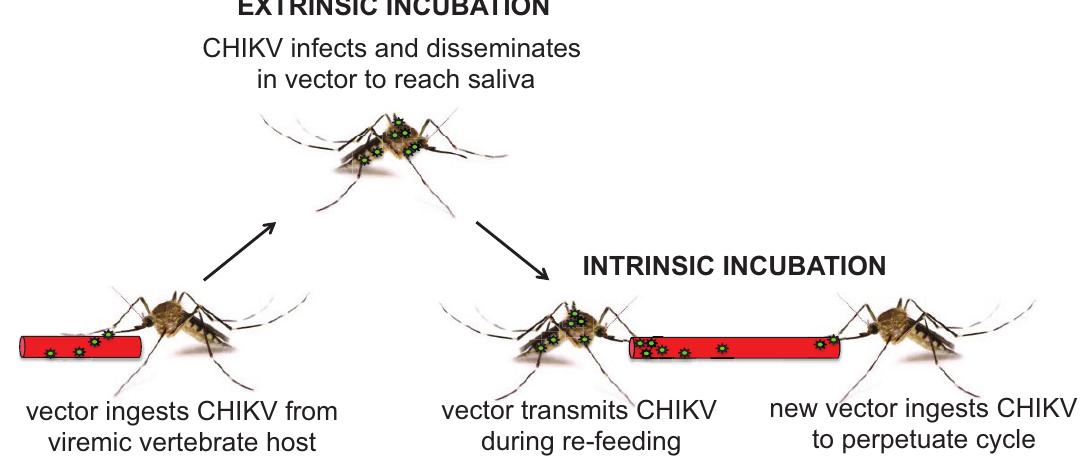
Figure 2. Process of infection and transmission of CHIKV by mosquito vectors. Vector mosquitoes ingest CHIKV from viremic vertebrate hosts during bloodfeeding. During the extrinsic incubation period that occurs in the vector, CHIKV infects the midgut and disseminates through the body cavity to infect salivary glands for secretion into saliva. Re-feeding vectors transmit CHIKV to vertebrate hosts by expectorating virus in saliva. New vectors perpetuate the CHIKV cycle by ingesting virus during intrinsic incubation, a period of viremia in the vertebrate host. Vector competence assays test infection, dissemination, and transmission of CHIKV after extrinsic